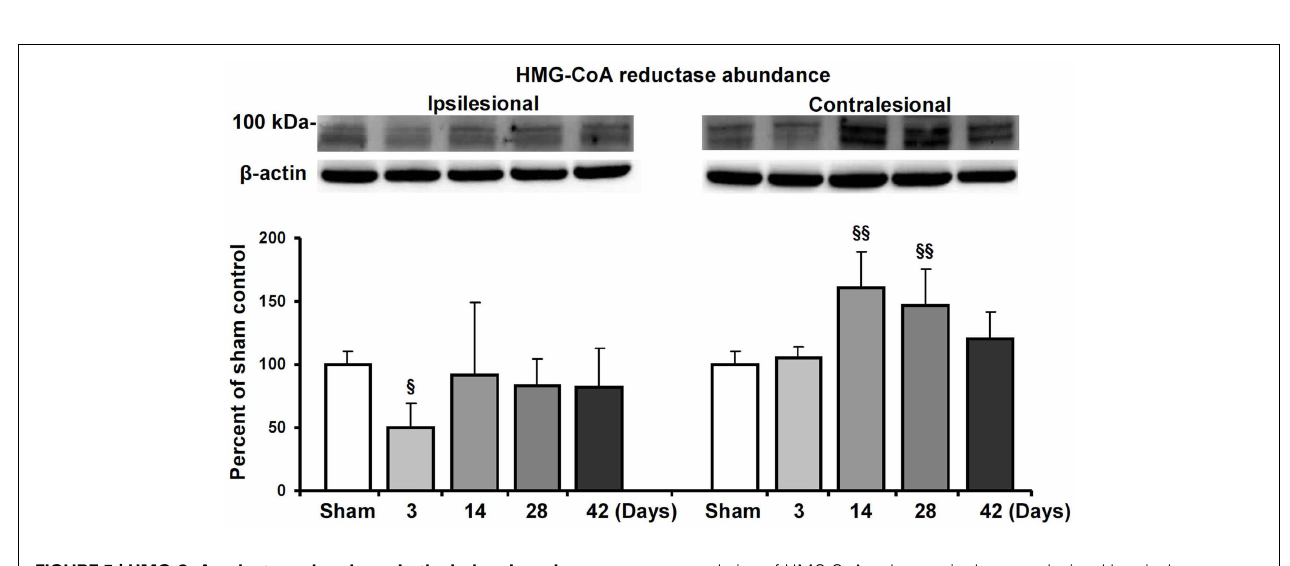
FIGURE 5 | HMG-CoA reductase abundance in the ischemic and contralesional hemisphere .Western blot analysis of the ~100kDa double band of HMG-CoA reductase at various reperfusions times following 30min MCAO. Representative blots are also shown. Note the